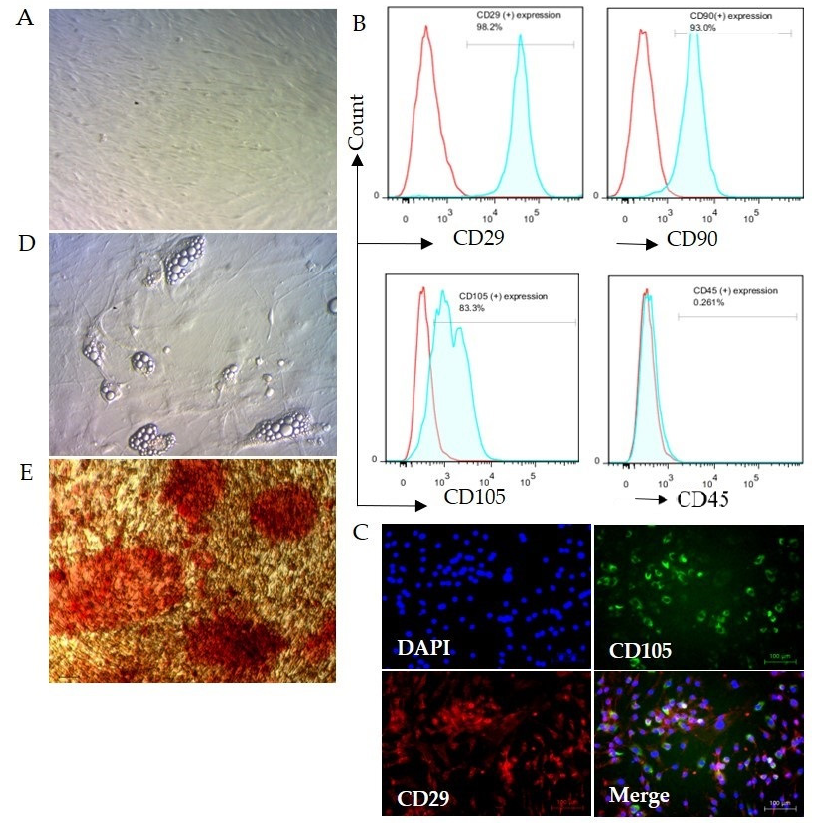
Figure 2. Mouse adipose stem cell (ASC) isolation and confirmation. ( A ). Morphology of ASC shows regular fibroblastic cell morphology. ( B ). Flow cytometric analysis of cultured ASC at 3rd passage. ASC was positive for CD29, CD90, and CD105 and negative for CD45, which confirms the purity of ASC. ( C ). Immunofluorescence staining confirmed the expression of CD29 and CD105 in ASCs. The nucleus was stained with DAPI. ( D , E ). Confirmation of the multipotency of ASC. ( D ). Adipogenic differentiation. Oblate-like cell morphology and numerous lipid droplets can be visualized without specific staining. E. Osteogenic differentiation. The cells developed a cluster-shaped structure and showed positive red staining with alizarin red staining, confirming the multipotency of ASC.